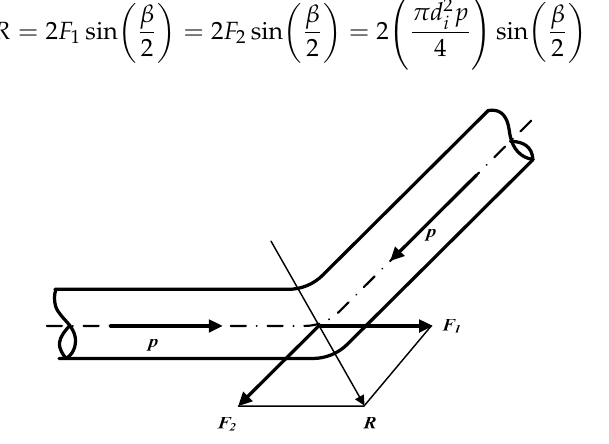
Figure 2. Elbow force diagram.